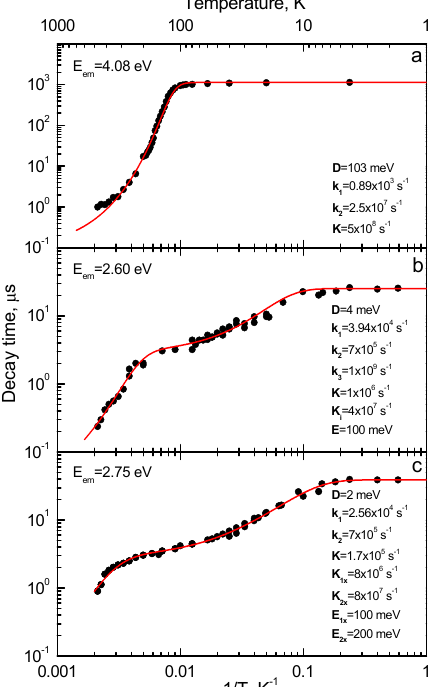
Figure 5. Temperature dependences of decay times measured for ( a ) the UV emission, ( b ) the 2.6 eV emission and ( c ) the 2.75 eV emission of Lu 3 Al 5 O 12 :Bi. The circles are experimental data. Solid lines are the best fits of the two or three excited-state level models (Figure 6 and Figure 10) to the experimental data (for details see the text). The parameters of the fits are reported in the figures. ( a ) E exc = 4.6 eV, E em = 4.1 eV; ( b ) E exc = 4.7 eV, E em = 2.4 eV; ( c ) E exc = 5.3 eV, E em = 3.2 eV. See also [16–18]. Presented with the publisher’s permission.